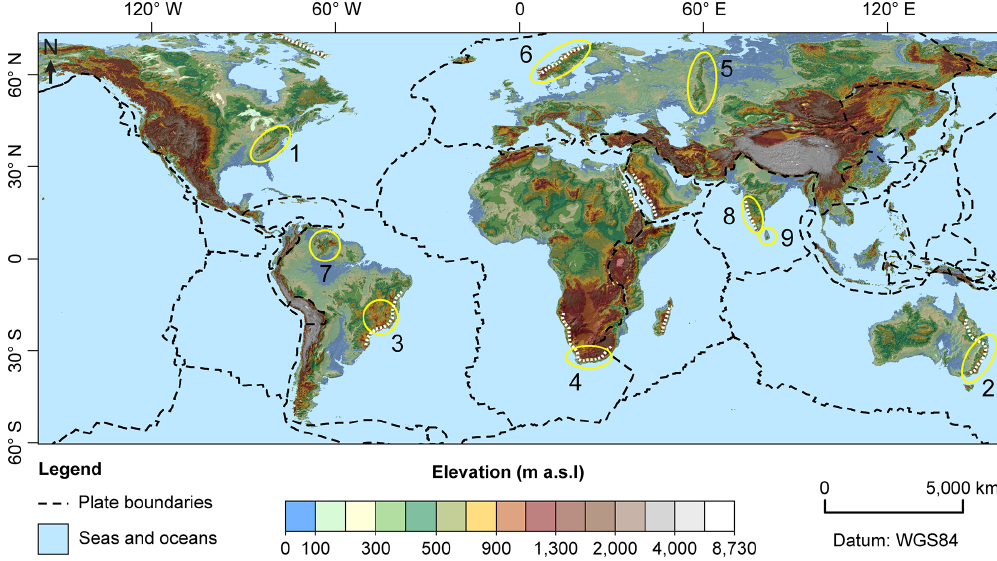
Figure 1. Global elevation and striking examples of high-relief ancient mountain belts. Post-orogenic settings highlighted by yellow el- lipses: (1) the Appalachian Mountains, (2) SE Australia, (3) SE Brazil, (4) the Cape Mountains, (5) the Ural Mountains, (6) the Scan- dinavian Caledonides, (7) the Guyana Shield, (8) the Western Ghats, and (9) the Sri Lanka orogen. Dotted white lines represent high- elevation passive margins. We extracted elevation data from the US Geological Survey’s (USGS) Global Multi-resolution Terrain Elevation data 2010